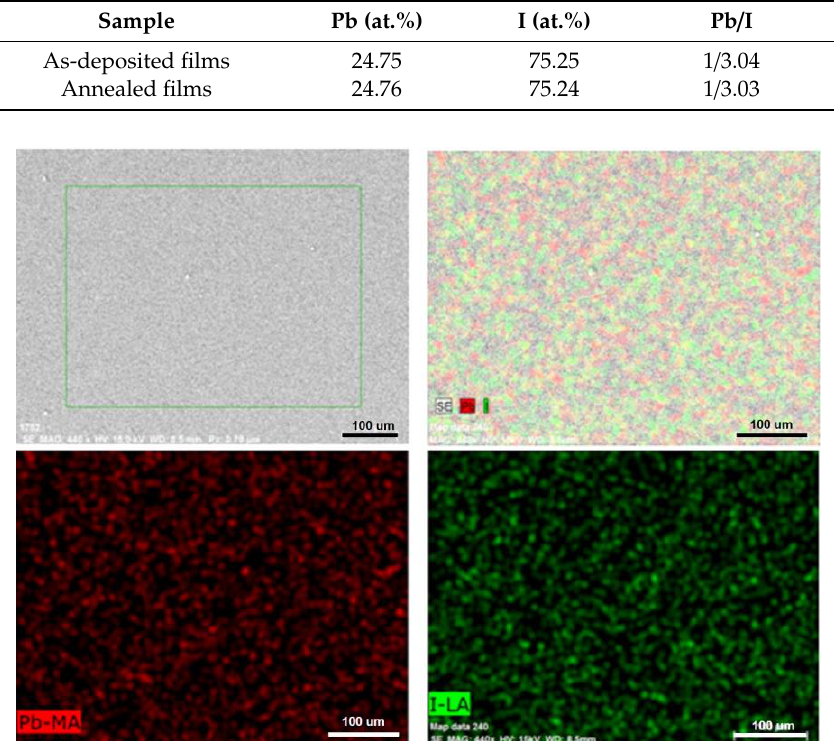
Figure 3. XRD patterns ( a ) and FWHM ( b ) and average crystalline size ( c ) of as-prepared and solvent- annealed films.